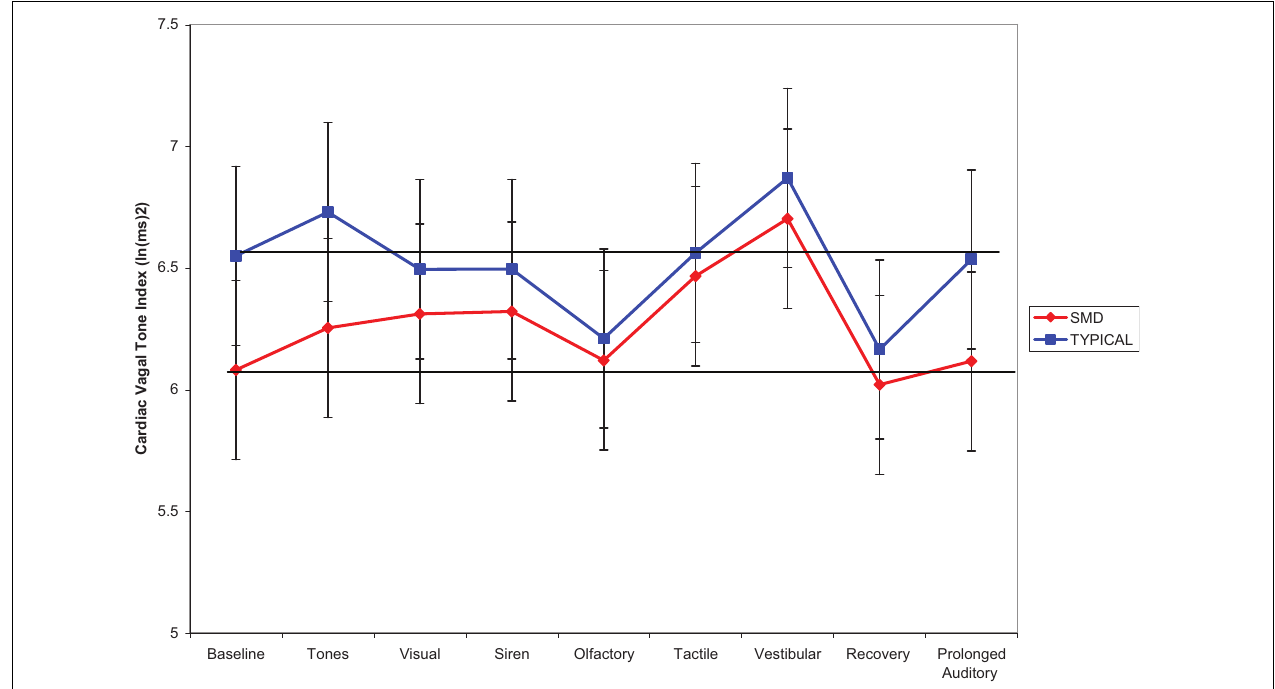
FIGURE 1 | Mean VT during Sensory Challenge Protocol for SMD versus TYP. (Horizontal line drawn to indicate baseline level for each